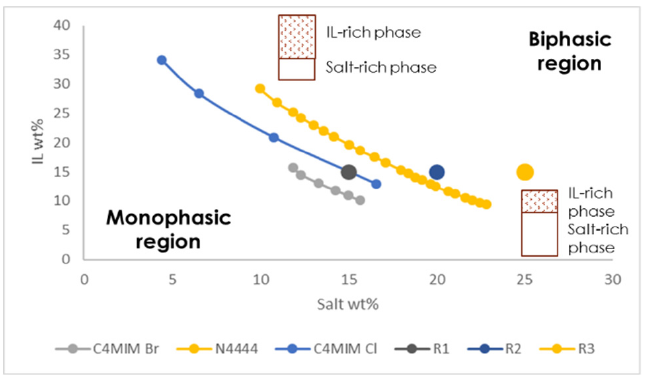
Figure 2. Binodal curve for the determination of weight ratio of IL, salt buffer (Na 2 CO 3 or Na 2 CH 3 CO 2 ) and water to produce biphasic systems. R1, R2 and R3 display the composition of the ATPS made with [C4Mim]Br − , [C4Mim]Cl − and [N4444]Br − , respectively.